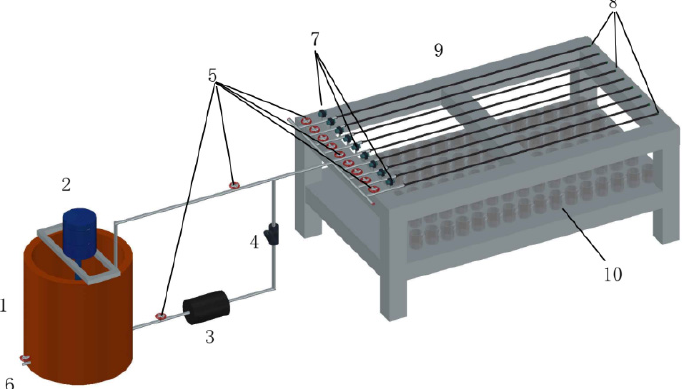
Figure 2. Test system layout. Note: (1). Water supply tank; (2) mixer; (3) water pump; (4) filter; (5) water inlet valve; (6) water source drain valve; (7) pressure sensor; (8) water outlet valve; (9) emit- ters; (10) measuring cup. Description: 1. The filter (4) is used to avoid accidental larger particles